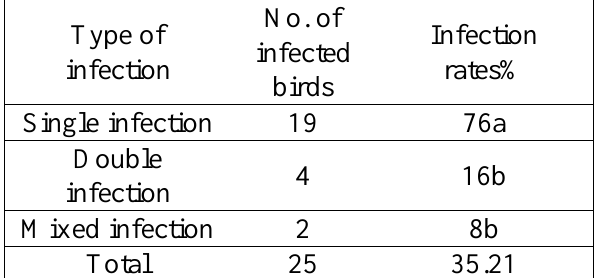
Table 3: Types of infections with nematodes and Eimeria in